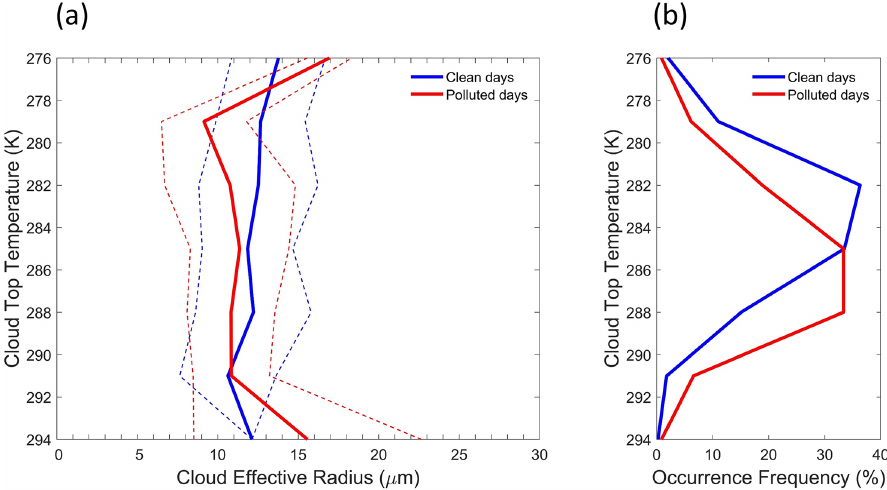
Figure 8. Multiyear (2005–2017) (a) relationship of cloud-top temperature (CTT) and cloud effective radius (CER). Plotted are the mean (solid line) and 1 standard deviation (dashed line) of CER for each 3K interval and (b) frequency of occurrence of CTT. Clean and polluted days are depicted with blue and red lines, respectively. Both (a, b) are constrained to CWP group 9 (150 ≤ CWP <